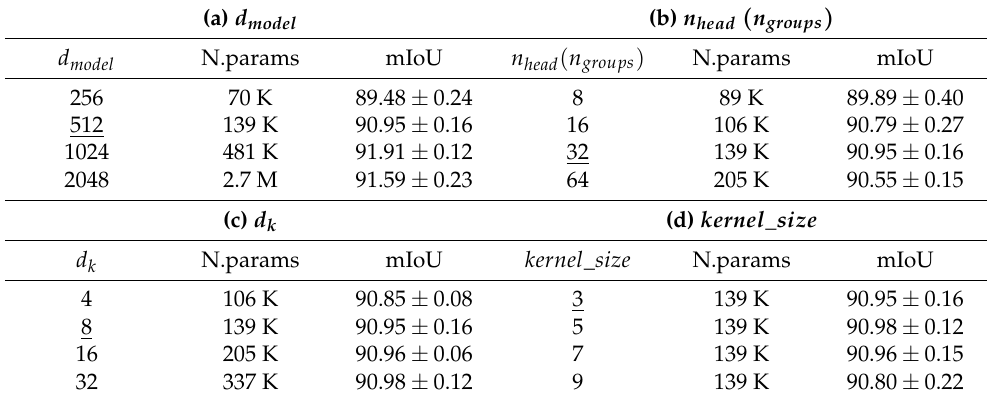
Table 6. Influence of four hyperparameters of GL-TAE on the performance of TimeSen2Crop. Underlines are default parameter